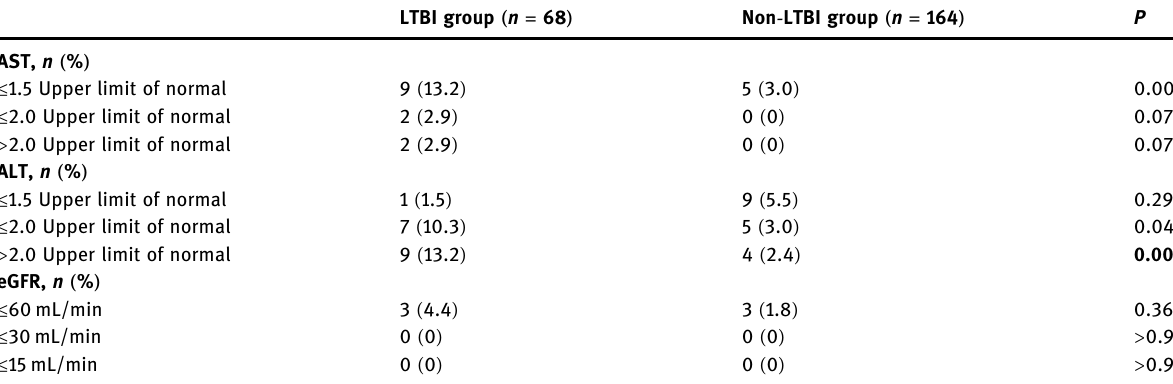
Table 3: Liver and renal function LTBI group ( n = 68 ) Non - LTBI group ( n = 164